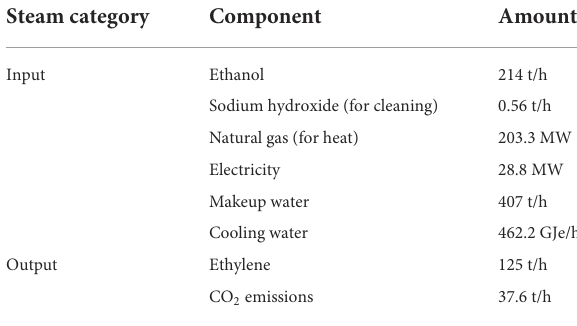
TABLE 2 A table showing the life cycle inventory of the reduction of ethanol to ethylene [derived from Yang et al.